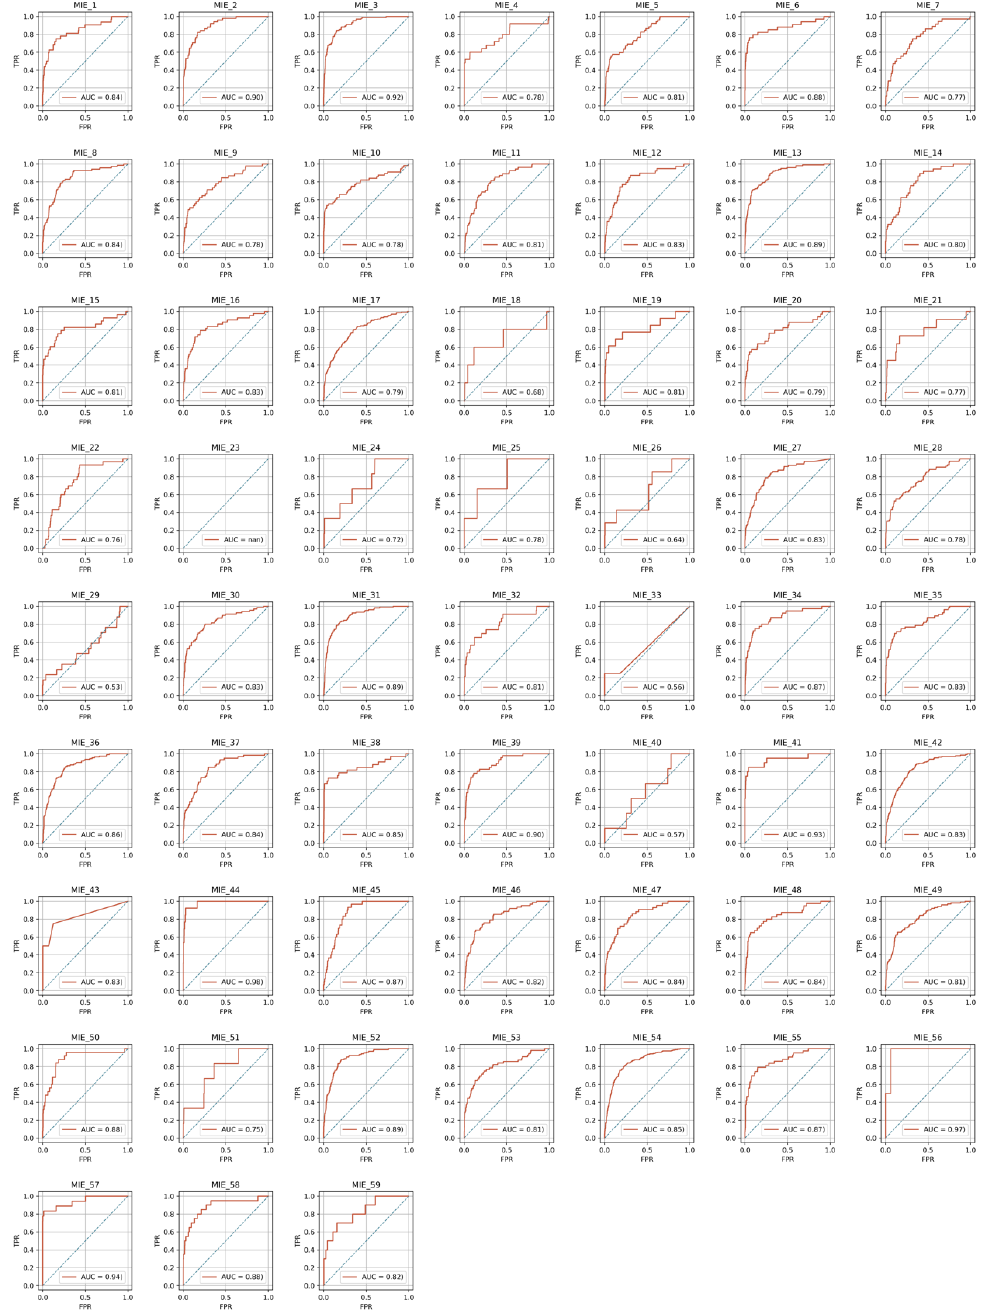
Figure 2. Receiver operating characteristic (ROC) curves with the test set in the case of criteria 40.